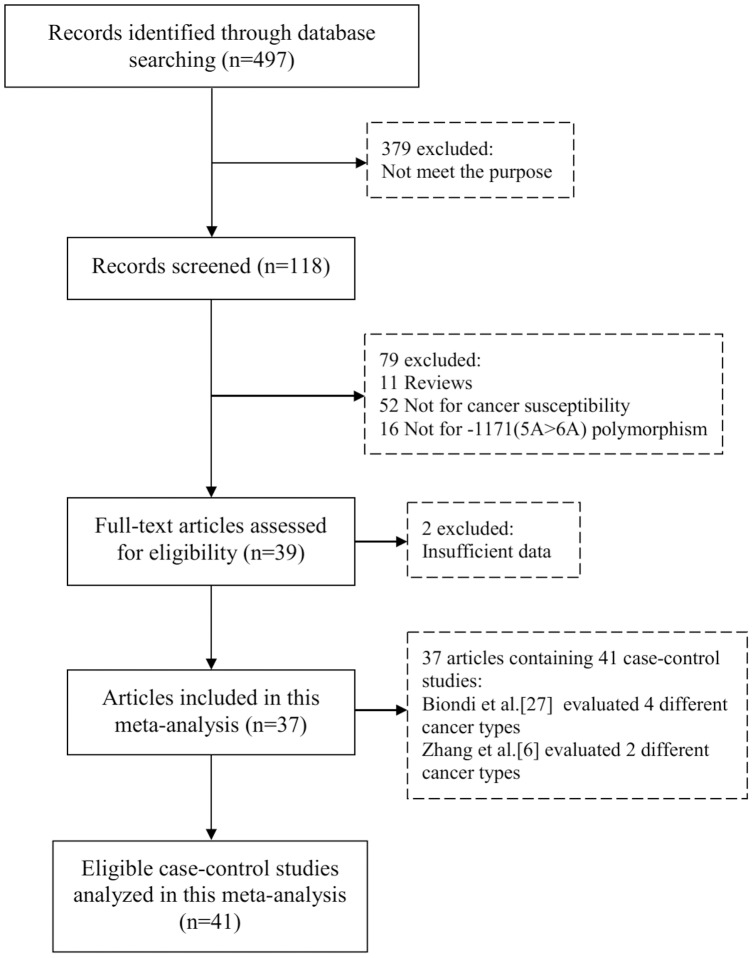
PRISMA Flow Chart.